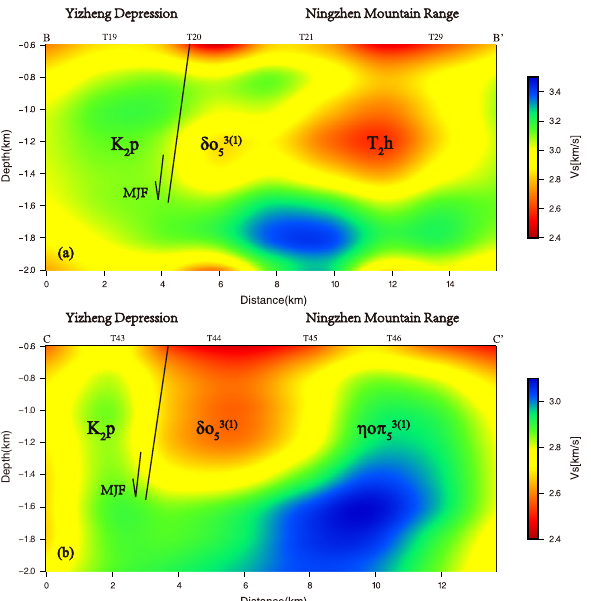
Figure 9. Cross-section of the V s model along ( a ) BB’ and ( b ) CC’. The MJF, K 2 p, δo 5 3 (1) , T 2 h, and ηοπ 5 3(1) represent the Mufushan-jiaoshan fault, the Pukou Formation sandstone of Mesozoic, the quartz diorite of late Yanshan, the Huangmaqing formation sandstone of Middle Triassic, and the porphyritic quartz diorite, respectively.